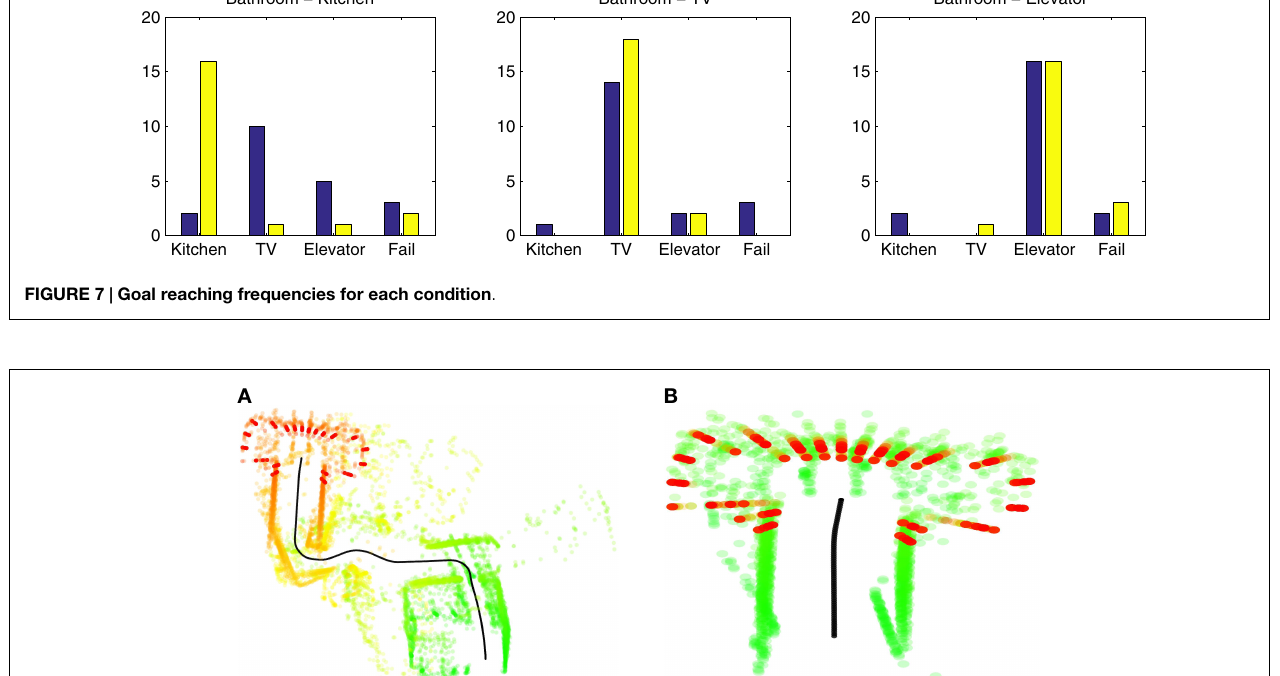
FIGURE 8 | (A) Internal simulation from the storage room (Area 1, Figure 4 ), here depicted in green, to the TV (Area 4), depicted in red. The simulation diverges from the path indicated by the active context (ToTV) and terminates in a sensory–motor pattern more similar to the elevator (Area 6). (B) Unsuccessful